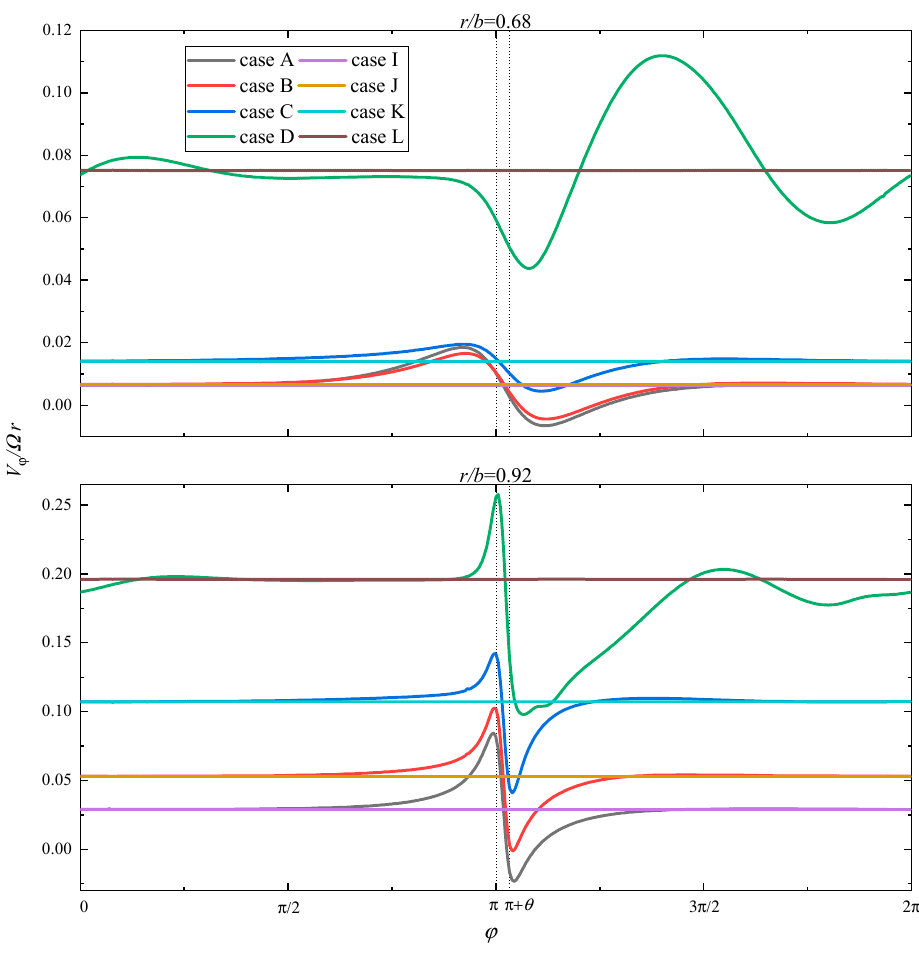
Figure 6. β curves with different Re ϕ for C w = 10,137, E = 0.2, θ = 0.1 at z / s = 0.5. Figure 6. β curves with different (cid:1844)(cid:1857) (cid:3101) for (cid:1829) (cid:3050) = 10,137 , (cid:1831) = 0.2 , (cid:2016) = 0.1 at z / s = 0.5. Figure 6. β curves with different (cid:1844)(cid:1857) (cid:3101) for (cid:1829) (cid:3050) = 10,137 , (cid:1831) = 0.2 , (cid:2016) = 0.1 at z / s = 0.5.